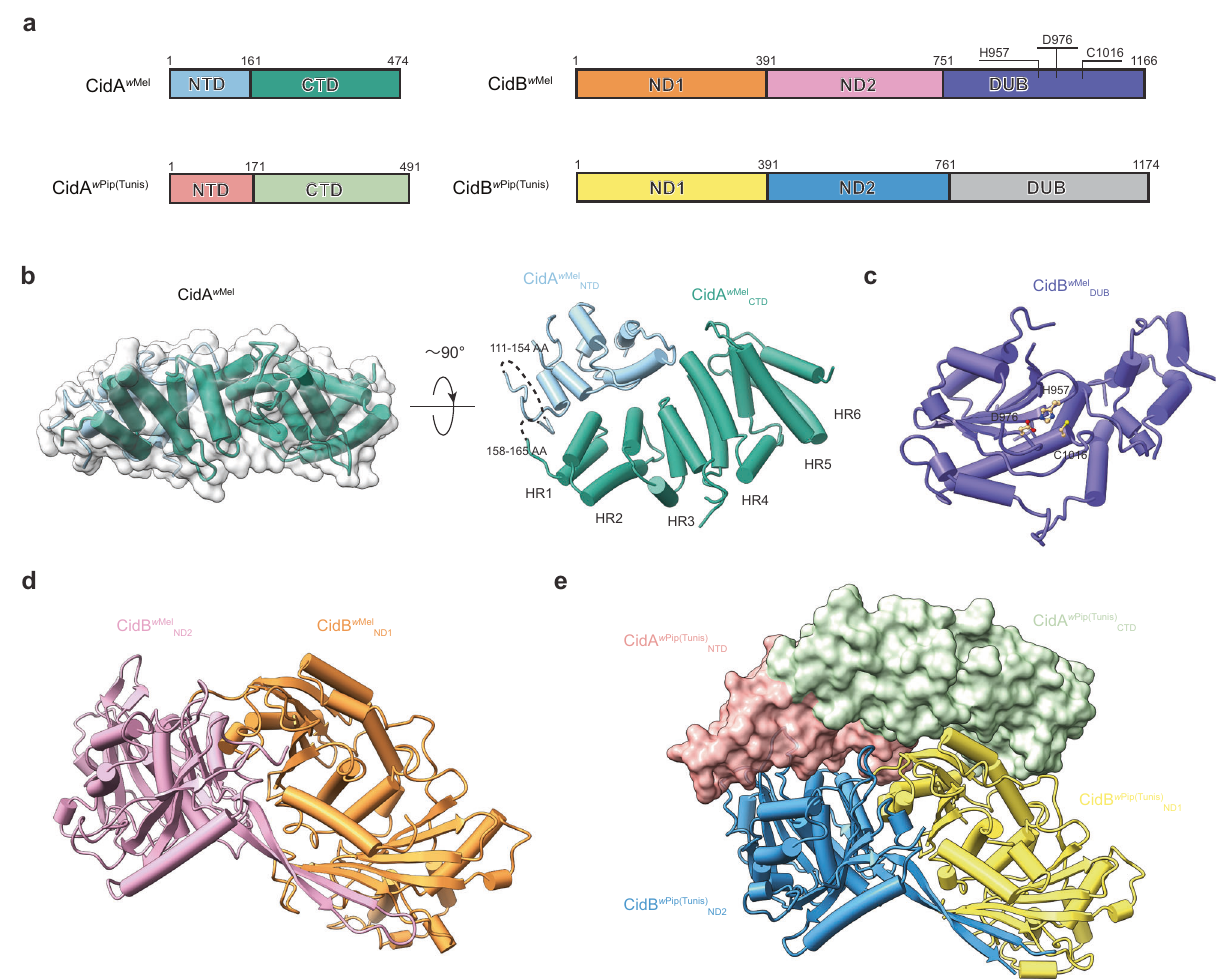
Fig. 1 Crystal structures of CidA w Mel and CidB w Mel DUB , and a model of CidB w Mel ND1-ND2 reveal the molecular basis for CI. a CidA w Mel and CidB w Mel , and CidA w Pip and CidB w Pip form alternative two-gene CI systems. Each domain is assigned a unique color. b CidA w Mel contains mostly α -helices. The C-terminal domain contains six HEAT repeats (HR1-HR6). Residues 111-154 and 158-165 are disordered. c CidB w Mel DUB consists of a fi ve-stranded β sheet fl anked by α helices on both sides. The active center residues are labeled and shown as balls and sticks. d A model for CidB w Mel AlphaFold. e The crystal structure of the CidA w Pip(Tunis) -CidB w Pip(Tunis) ND1-ND2 complex. NTD: N-terminal domain; CTD C-terminal domain; ND nuclease domain; DUB deubiquitylase domain; AA amino acids; HR HEAT